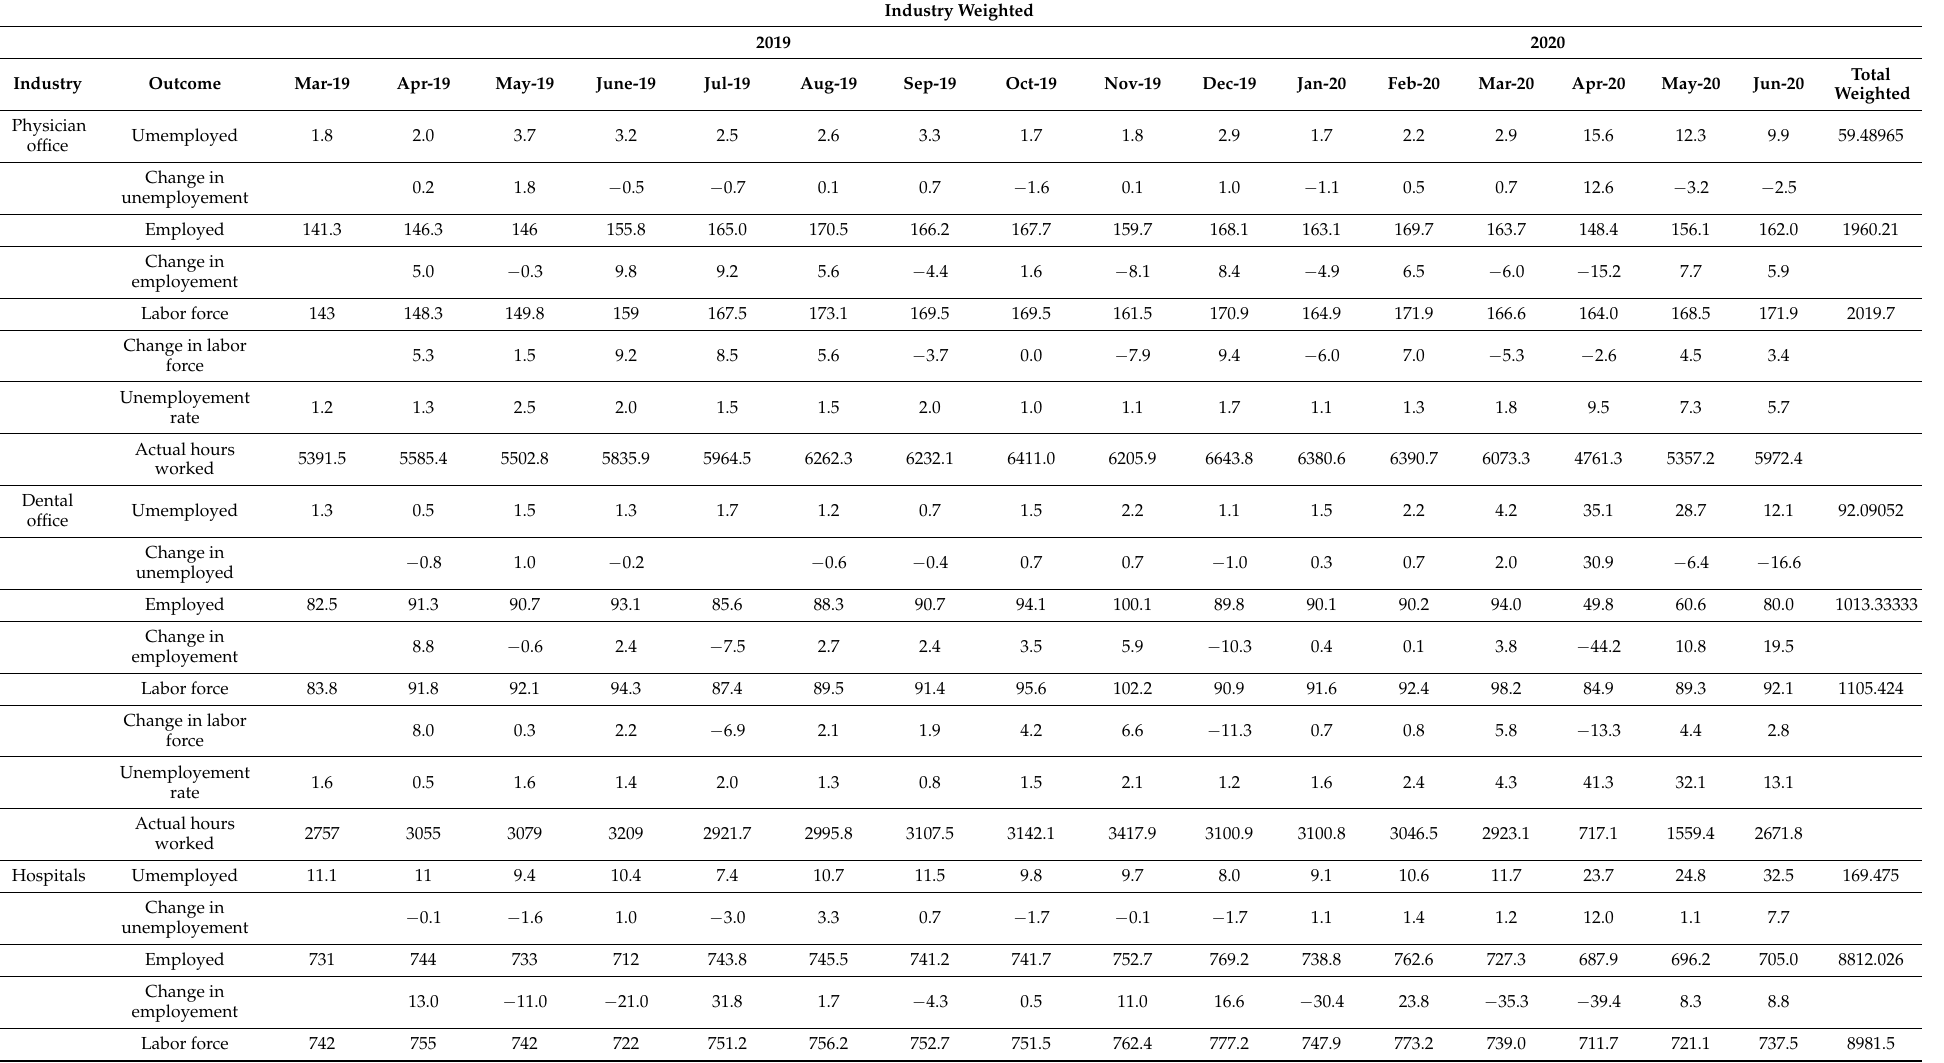
Table A1. Labor market outcomes across healthcare industries (March 2019–June